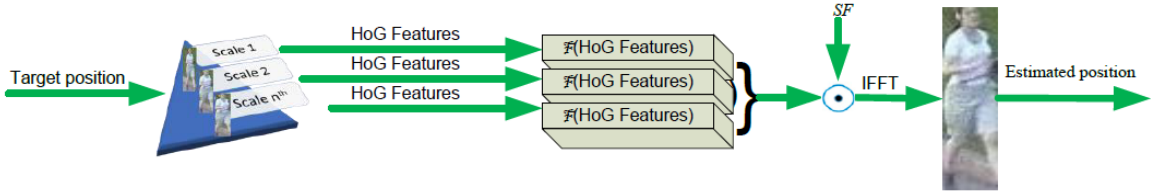
Figure 2. Scale handling mechanism. Multiple sub-windows around the estimated location are sampled. These windows are obtained by multiplying the previous target window with different scale factors. Sub window with highest APCE and CSRM value is considered as correct scale estimation of object.